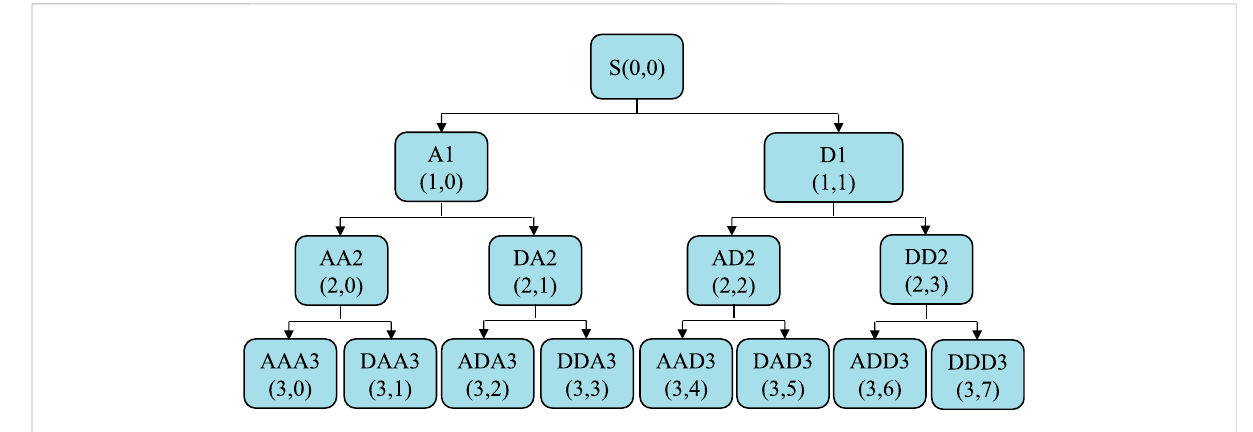
FIGURE 5 Tree structure of three-layer wavelet packet